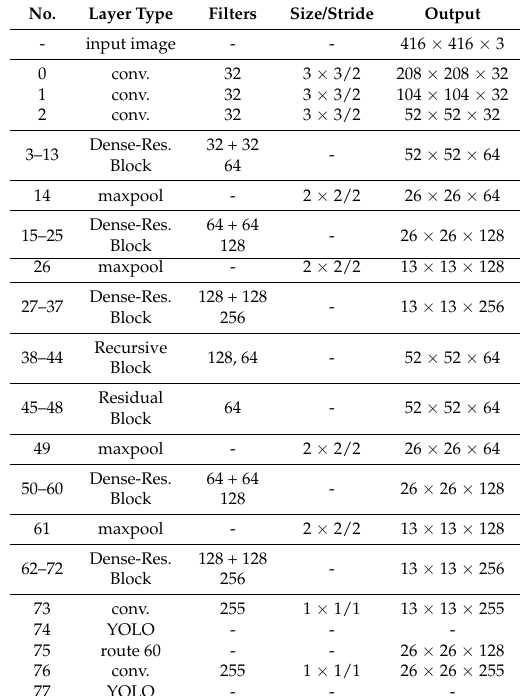
Table 2. Description of SF-YOLO (medium)